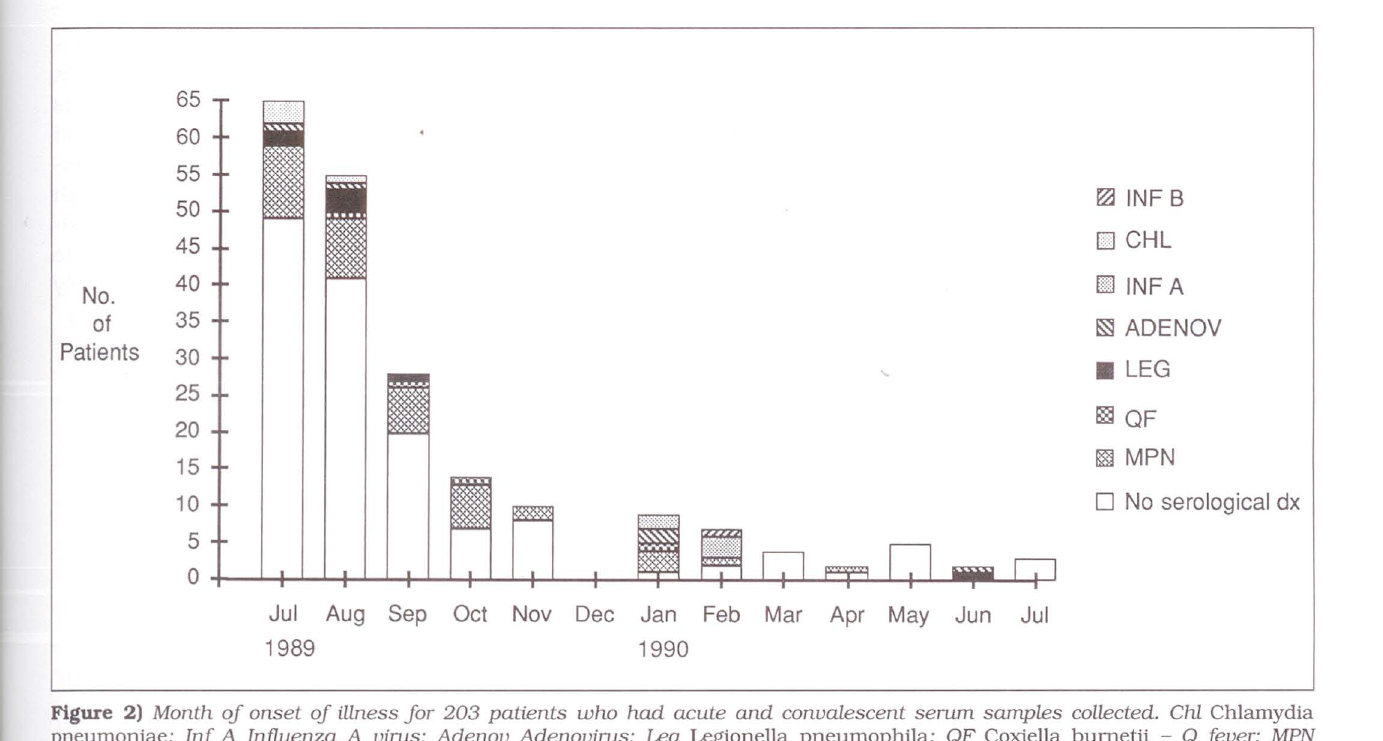
Figure 2) Month of onset of illness for 203 patients who had acute and convalescent serum samples collected. Chl Chlamydia pneumoniae; Irif A Influenza A virus; Adenov Adenovirus; Leg Legionella pneumophila; QF Coxiella bumetii - Q fever; MPN Mycoplasma pneumoniae; dx Diagnosis; the clear space represents the number of patients who had no antibody rise to the agents indicated above